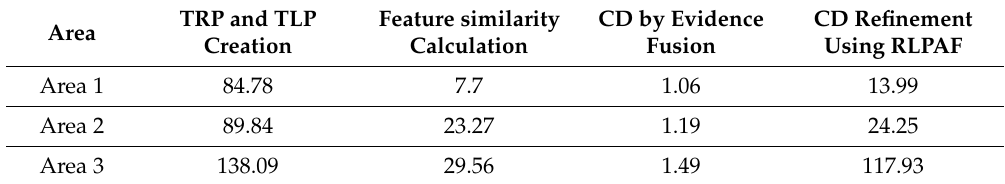
Table 5. Method e ffi ciency (unit: seconds).